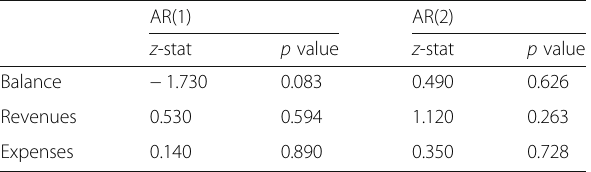
Table 9 Arellano-Bond test for autocorrelation of order one and two